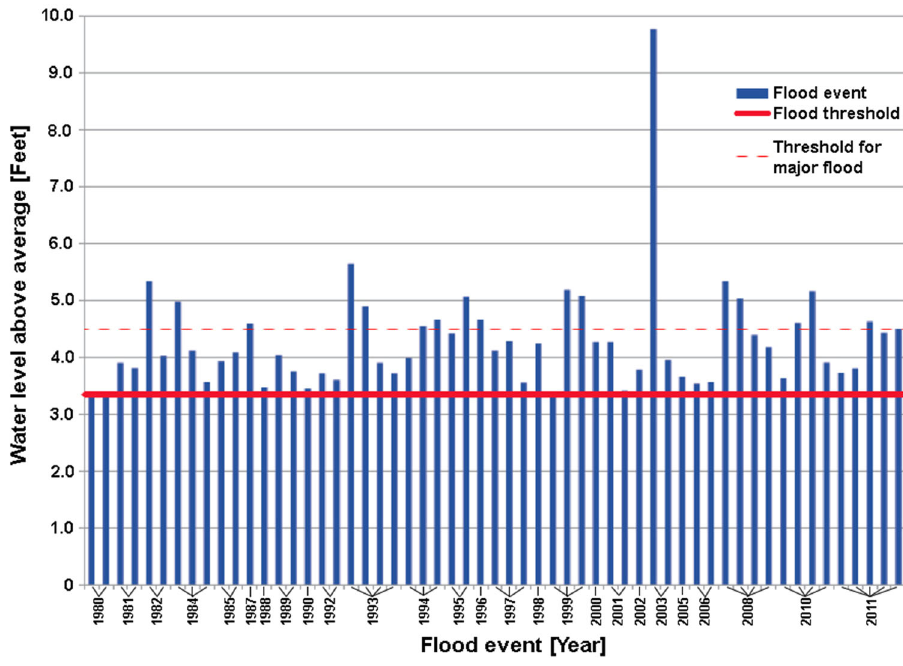
Fig. 2 Nilwala River flood water levels from 1980–2011 at Pitabeddara, 15 km upstream of Akuressa. The red solid line indicates the water level where floods occur (Ministry of Disaster Management Sri Lanka 2012) and the dashed line on 4.5 feet marks the threshold for major floods (Sooriyabandara